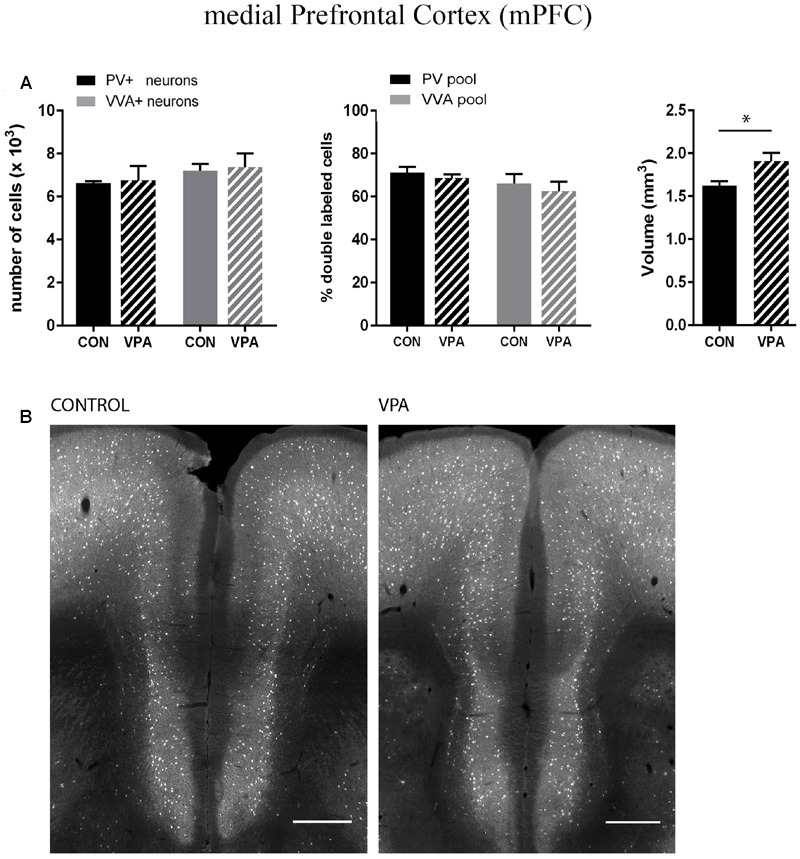
(A) Left: Stereological estimations of PV+ (black) and VVA+ (gray) cells in the mPFC of PND25 in utero saline (CON) or VPA treated male mice (N = 5 each). Middle: percentage of PV+ cells surrounded by VVA (black) and VVA+ cells showing PV expression (gray) in CON and VPA mice. Right: Volume of the ROI; i.e., the mPFC. Asterisks represent ∗P ≤ 0.05. (B) Representative PV immunofluorescence images from the mPFC of a CON and VPA mouse are shown. Scale bar: 200 μm. All data are expressed as mean ± SEM.